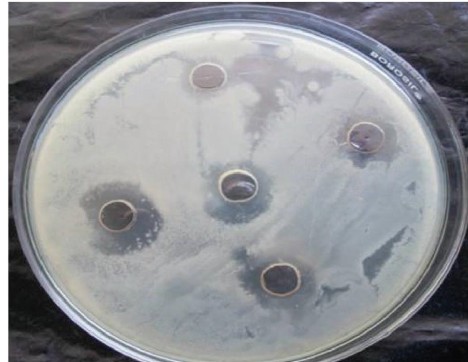
Figure 6: Te image showing good inhibitory action of synthesized silver nanoparticles on E . coli .